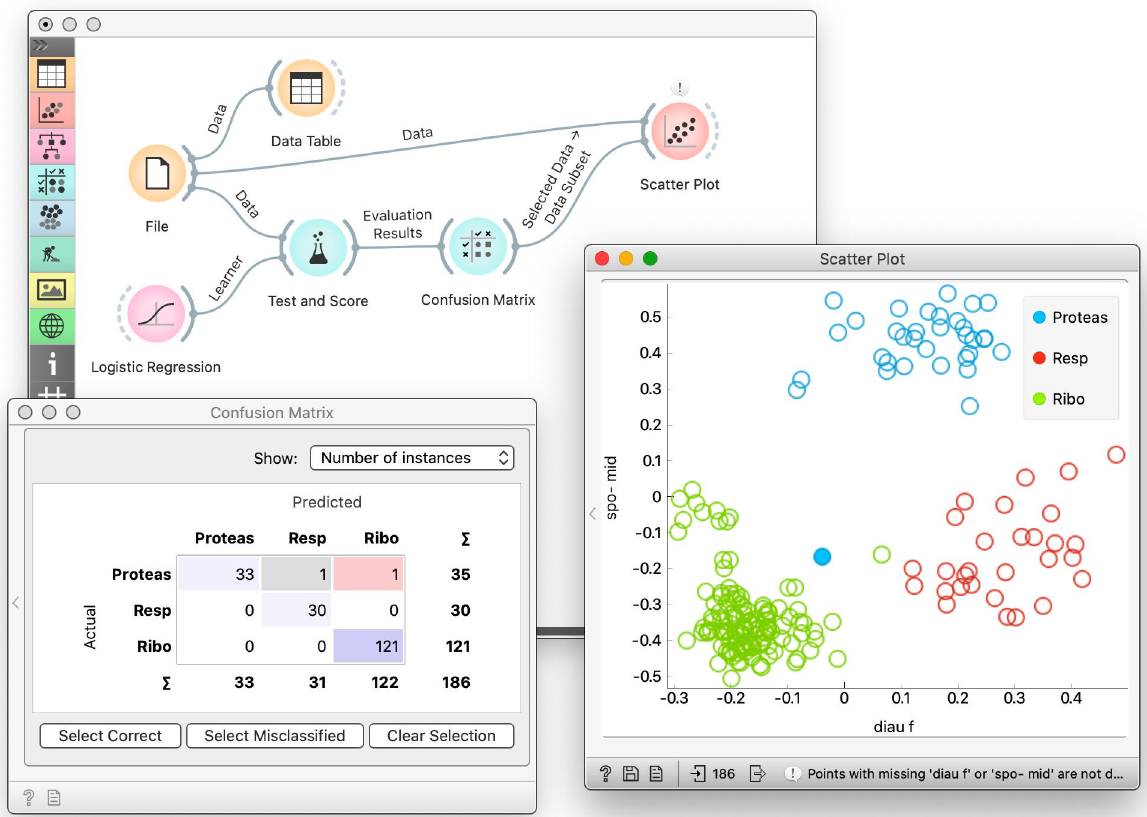
Fig 1. Orange data science toolbox. Orange provides data analysis components, also called widgets, assembled into a data analysis workflows through visual programming. The components typically encapsulate some data processing or modeling methods; they receive the input and submit the results to the output. Widgets in Orange are represented with icons with an input slot on the left and the output slot on the right. Users place widgets on the canvas and connect the inputs and outputs of the widgets. In this way, they define the data and information processing pipeline. The system processes the workflow on-the-fly: as soon as the widget receives the information, it would handle it and send out the results. In the workflow shown on the figure, the data pipeline starts with reading the data (File widget) and passes it to cross-validation (Test and Score), which also receives a learning algorithm on its input. Double-clicking the widget exposes its content. For instance, we pass cross-validation results to the Confusion Matrix, which shows that logistic regression misclassified only two data instances. We use the Scatter Plot to show the entire data set and also display selected data from the Confusion Matrix. Any change in selection in the Confusion Matrix would change its output. This would trigger the change in the Scatter Plot. With this composition of components, we turn this workflow into a visual explorative environment for examining cross-validation